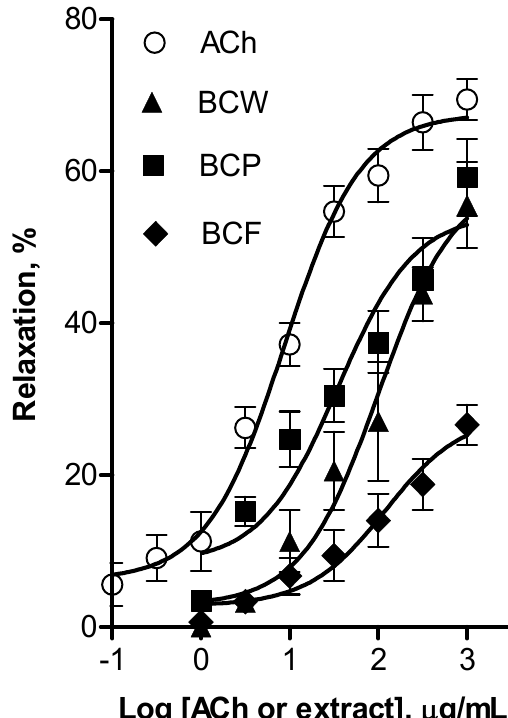
Figure 4. Concentration-response curves for the vascular relaxant effect of whole (BCW), peel (BCP) and flesh (BCF) black cherry and acetylcholine as positive control